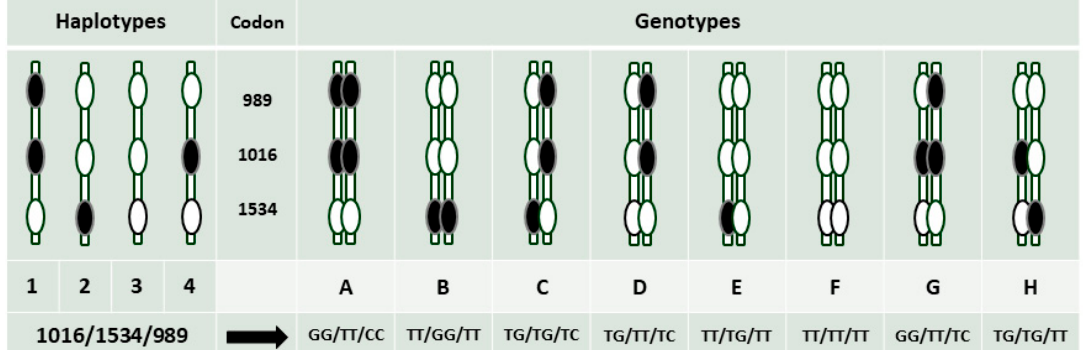
Figure 4. Putative Vssc haplotypes and observed genotypes in field (Shah Alam) (A–F) and IMR colony samples (A–G) of Aedes aegypti .